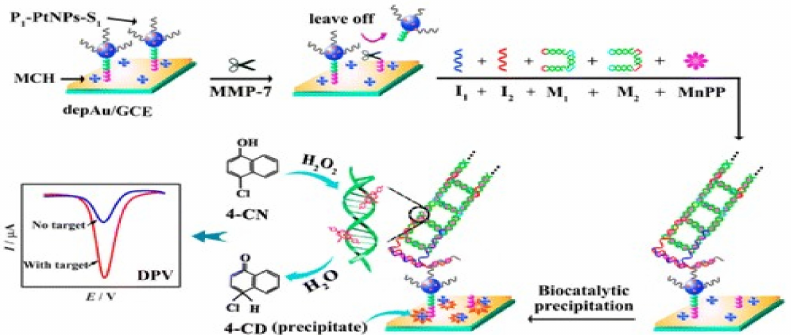
Figure 3. Schematic illustration of matrix metalloproteinases 7 (MMP-7) electrochemical biosensors